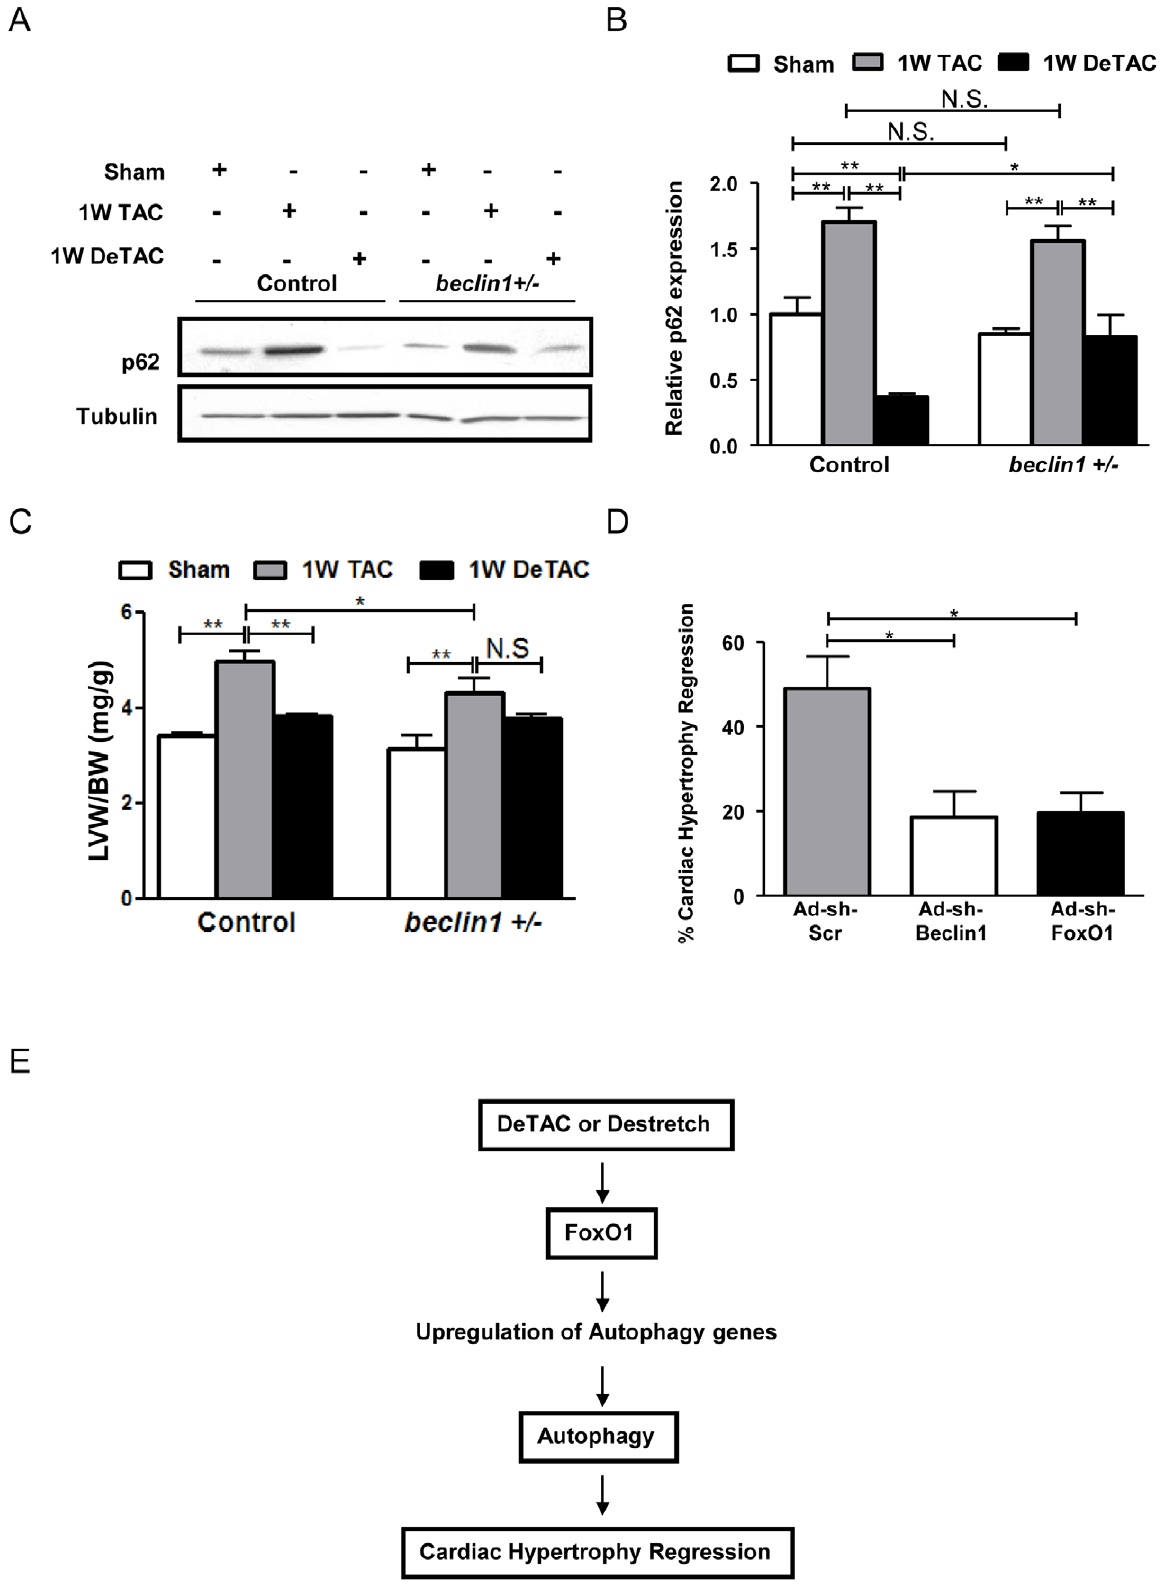
Figure 6. FoxO1 and autophagy are required for regression of cardiac hypertrophy. Control C57BL/6 mice and mice with heterozygous knockout of Beclin1 ( beclin1 + / 2 ) were subjected to 1W TAC and 1W DeTAC surgeries. A) Representative immunoblots. B) Densitometric analyses. C) Left ventricular weight/body weight (LVW/BW). D) Cultured cardiomyocytes were transduced with Ad-sh-Scr, Ad-sh-Beclin1 and Ad-sh-FoxO1 and